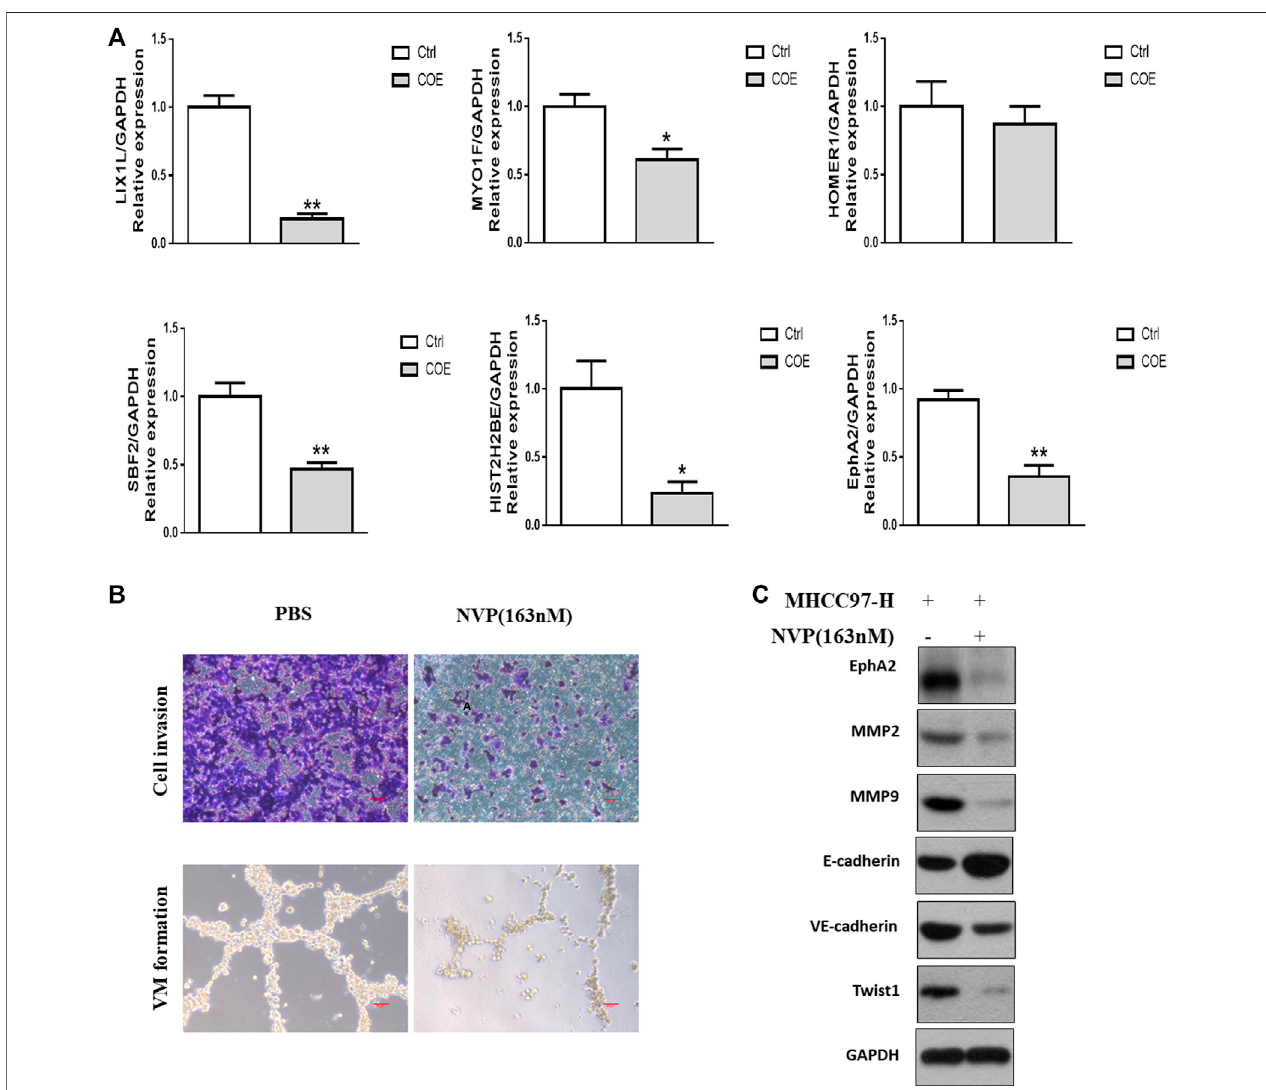
FIGURE 4 | Evaluation of targets derived from proteomics analysis. (A), RT-PCR assay for the most signi fi cantly down-regulated genes. p , p < 0.05, pp , p < 0.01, versusnegativecontrol.Ctrl,negativecontrol(PBS),Two-tailed t -test. (B) ,upperpanel,cellinvasionassay,scalebar,20 μ mlowerpanel,VMformationassay,scalebar, 50 µm NVP, NVP-BHG712. (C) , Western blotting analysis on the expression of VM related protein biomarkers after blocking EphA2.